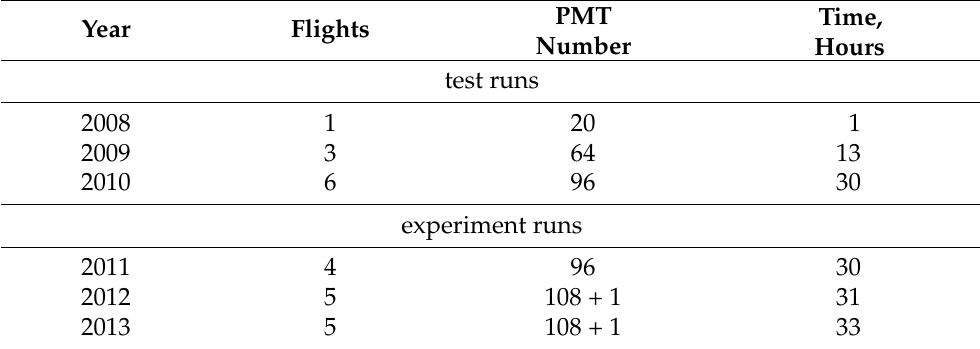
Table 1. The annual statistics of the SPHERE experiment on Baikal Lake. Time column lists total data taking time. The details on electronics can be found in